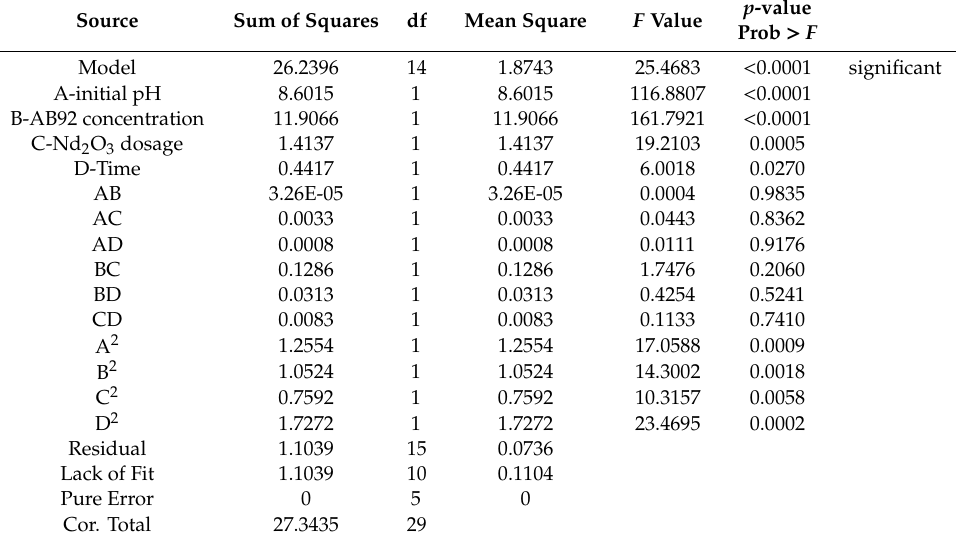
Table 4. Analysis of variance (ANOVA), lack of fit (LOF) test, regression coe ffi cients and the significance of the response surface quadratic model of adsorption of the dye